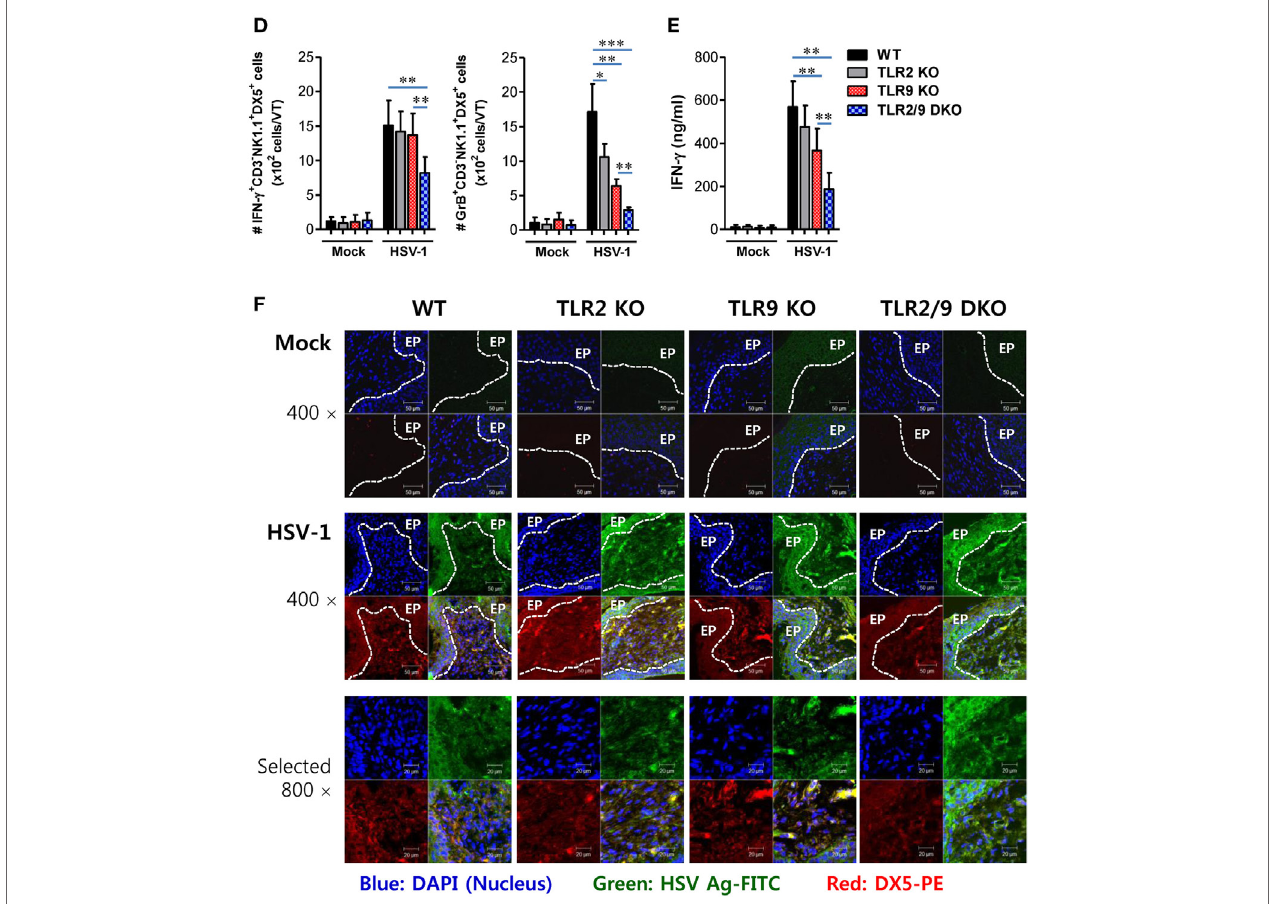
FigUre 4 | Reduced recruitment and activation of NK cells by the deficiency of TLR2 and TLR9 molecules. (a) NK cell infiltration of infected wild-type (WT), TLR2 KO, TLR9 KO, and TLR2/9 double knock-out (TLR2/9 DKO) mice. Cells were prepared from the vaginal tract (VT), iliac LNs (ILNs), and spleen (Spl) with collagenase digestion 0 and 2 days post-infection (dpi), and used for analysis of NK cells. The values in the dot-plots represent the average percentage plus SEM of NK1.1 + DX5 + NK cells after gating on CD3-negative cells ( n = 4–5). (B) Total accumulated NK cell number. The total number of accumulated CD3 − NK1.1 + DX5 + NK cells in the VT, ILN, and Spl was determined by flow cytometric analysis 2 dpi. (c) The frequency of IFN- γ and granzyme B (GrB)-producing cells in vaginal NK cells. The proportion of IFN- γ and GrB-producing cells in CD3 − NK1.1 + DX5 + NK cells was determined by intracellular staining after brief stimulation of vaginal leukocytes with PMA and ionomycin 0 and 2 dpi. The values in the plots represent the average plus SEM of IFN- γ or GrB-producing cells in NK1.1 + cells after gating on CD3 − NK1.1 + DX5 + NK cells ( n = 4–5). Vaginal leukocytes unstimulated with PMA and ionomycin were used for negative control. (D) The absolute number of IFN- γ or GrB-producing NK cells. The total number of IFN- γ or GrB-producing CD3 − NK1.1 + DX5 + NK cells was enumerated by flow cytometric analysis using intracellular and surface staining 0 and 2 dpi. (e) Secreted IFN- γ levels in vaginal lavages. Secreted IFN- γ levels were determined by ELISA 0 and 2 dpi using vaginal lavages. (F) Confocal microscopy of infiltrated NK cells. Sections of vaginal tissues obtained from herpes simplex virus (HSV)-infected mice were co-stained for HSV Ag (gB) (green), the nuclear stain DAPI (blue), and the NK cell marker DX5 (red) 2 dpi. Images are representative of sections (400 × ) from at least four mice, and the lower image is a selected area magnified by twofold (800 × ). White dot-line shows epithelial layer (EP layer). Sections of vaginal tissues obtained from uninfected mice were used for negative control group. Two-way ANOVA followed by Bonferroni post hoc testing was conducted in B . One-way ANOVA with repeated measurements and Bonferroni post hoc tests were performed in (D,e) . Data in the bar chart represent the average ± SEM of the levels derived from at least three independent experiments ( n = 3–4). * p < 0.05; ** p < 0.01; *** p < 0.001 comparing levels between the indicated